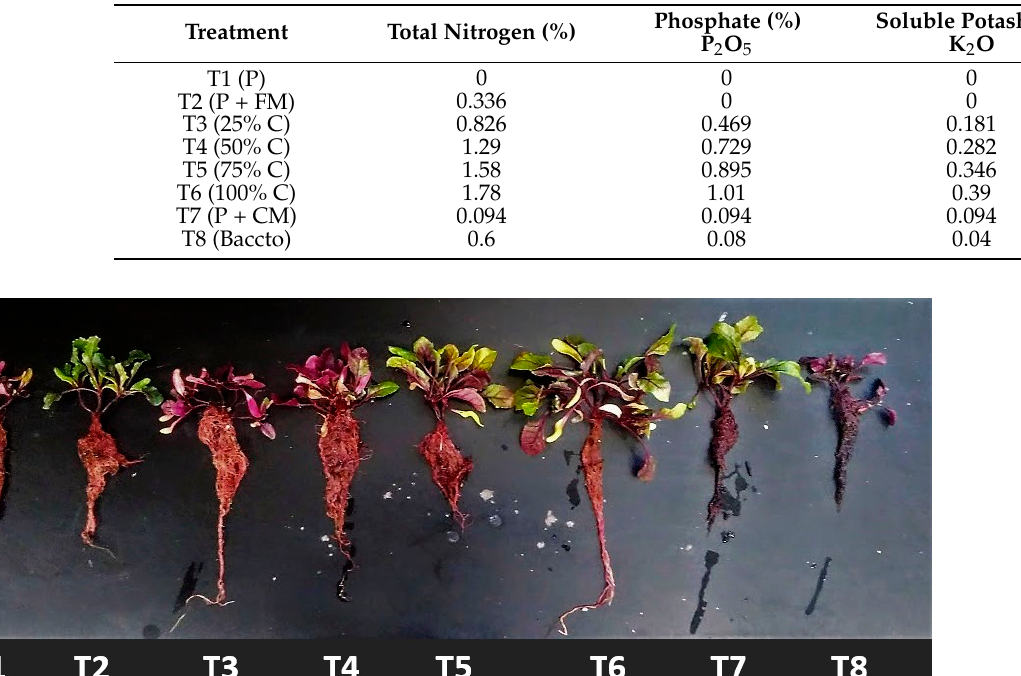
Table 5. Estimated macronutrient contents of each potting media treatment. T1 (P) and T8 (Baccto) are based on the product description. T2 (P + FM) and T7 (P + CM) are based on the product description of the fertilizers and the measured weight of Pro-Mix (Peat). T6 (100% C) is based on the soil test results of compost reported on April 12, 2021 (A & L Western Agricultural Laboratories, Modesto, CA, USA). T3 (25% C), T4 (50% C), and T5 (75% C) are based on the soil test results of compost and the measured weights of potting media substrates.